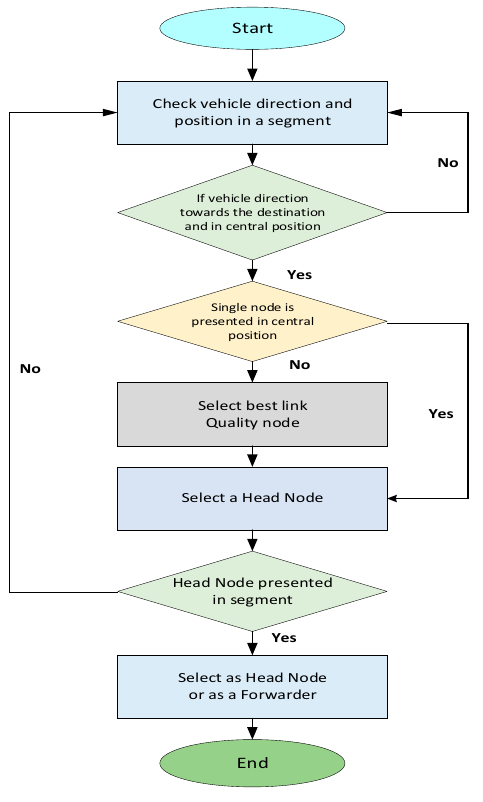
Figure 2. Flowchart of head node selection.